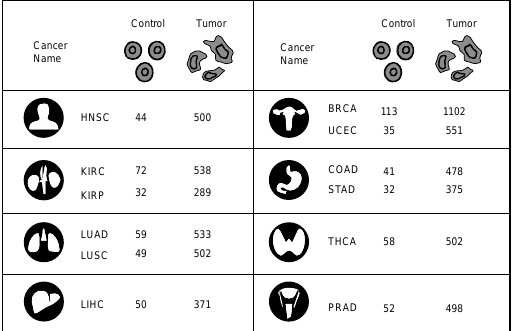
Figure 2. Distribution of samples from 12 human cancers. The diagram shows control and tumor samples from 12 human cancers analyzed in the study.